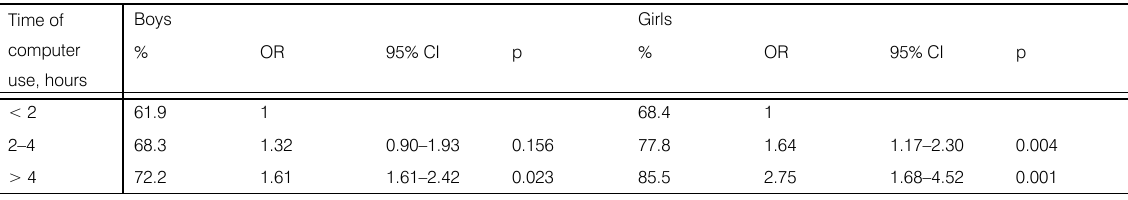
Table 2. The odds ratios and percentages of self–rated musculoskeletal complaints among 13–18–year–old boys and girls by daily time of computer use.